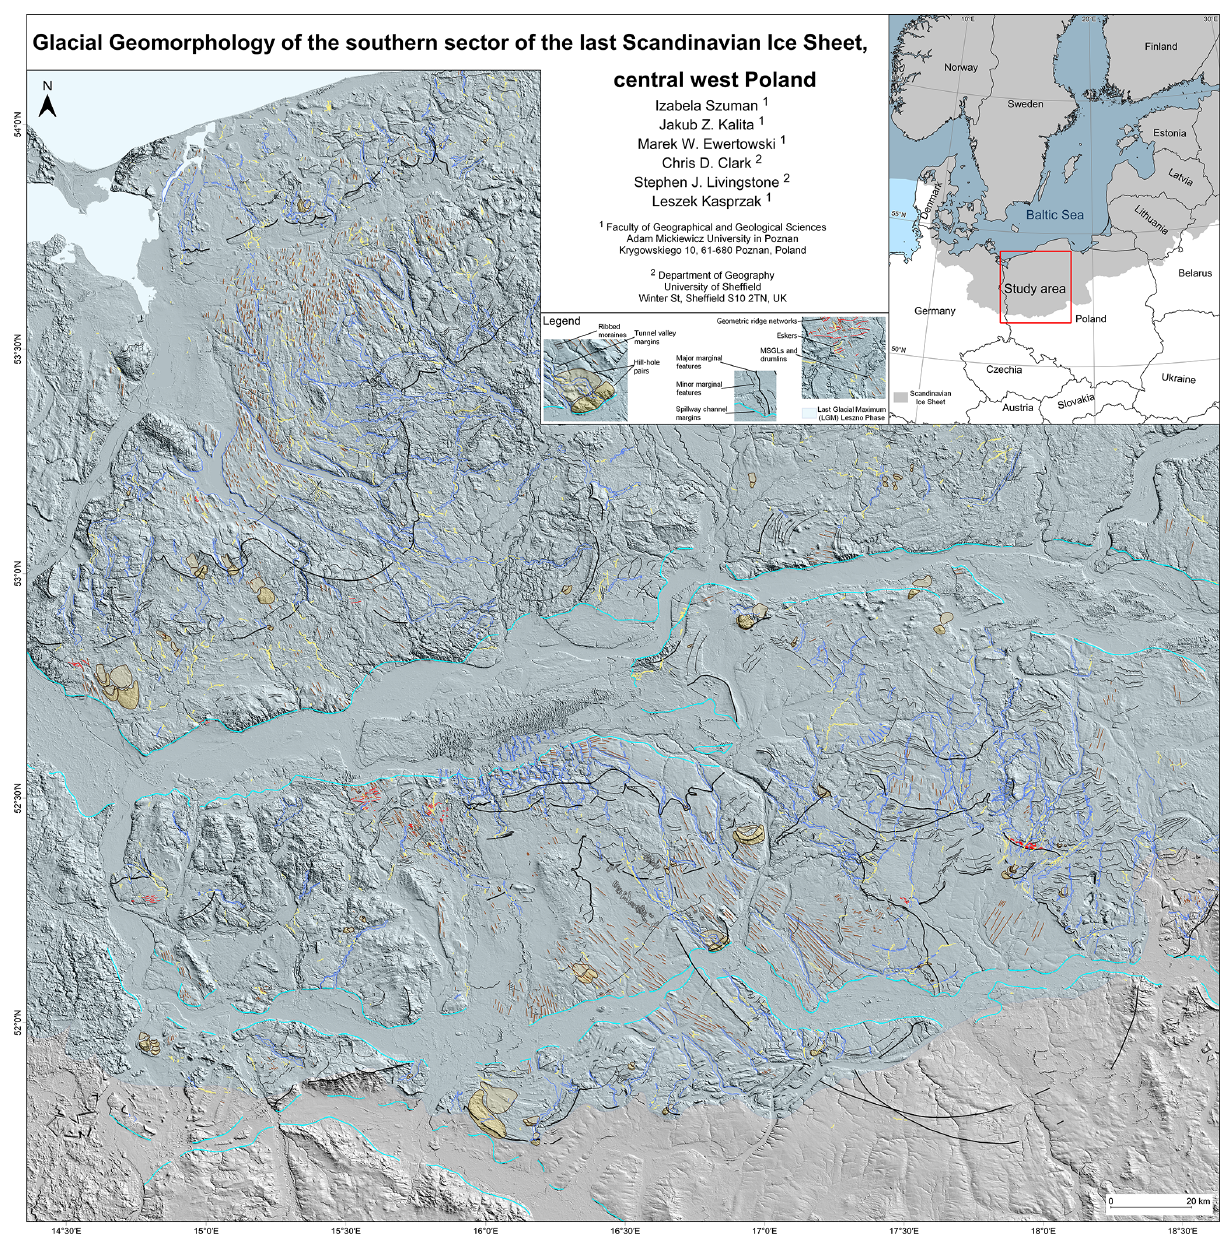
Figure 2. Glacial geomorphology of the southern sector of the last Scandinavian Ice Sheet, central west Poland. This is designed to be viewed at a scale of 1 : 500000 and will need downloading from the Supplementary material (Fig. S1 at https://doi.org/10.5281/zenodo.4570570) to identify all features (see Szuman et al.,